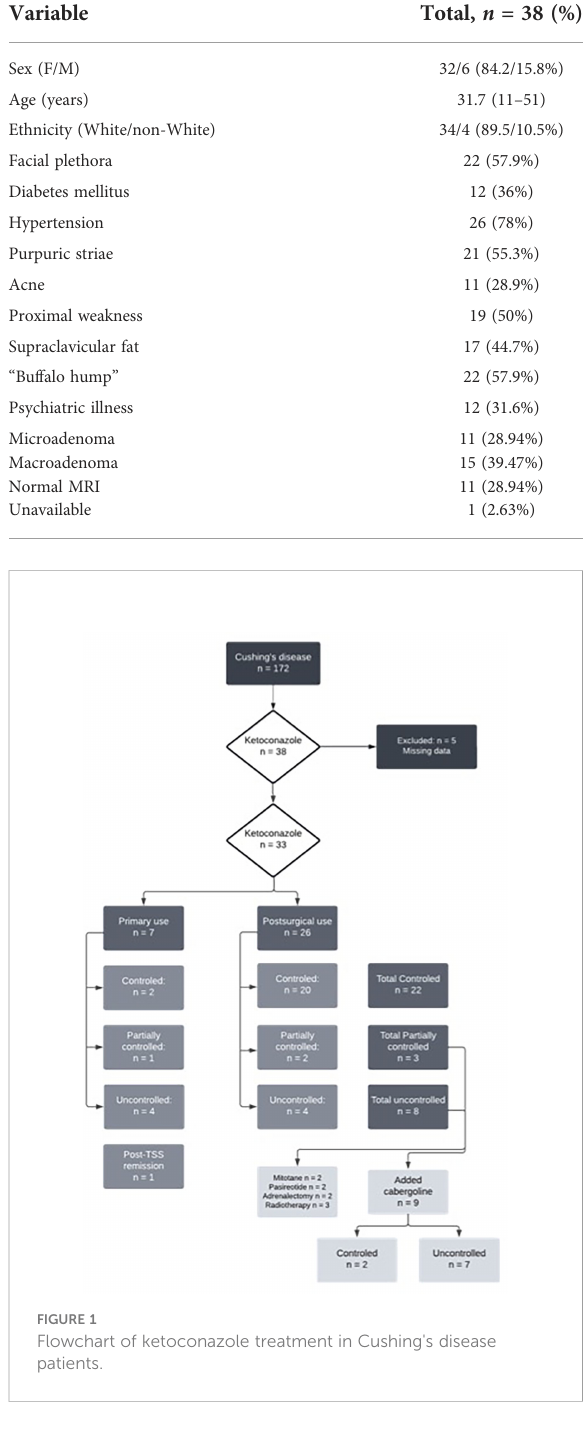
FIGURE 1 Flowchart of ketoconazole treatment in Cushing's disease